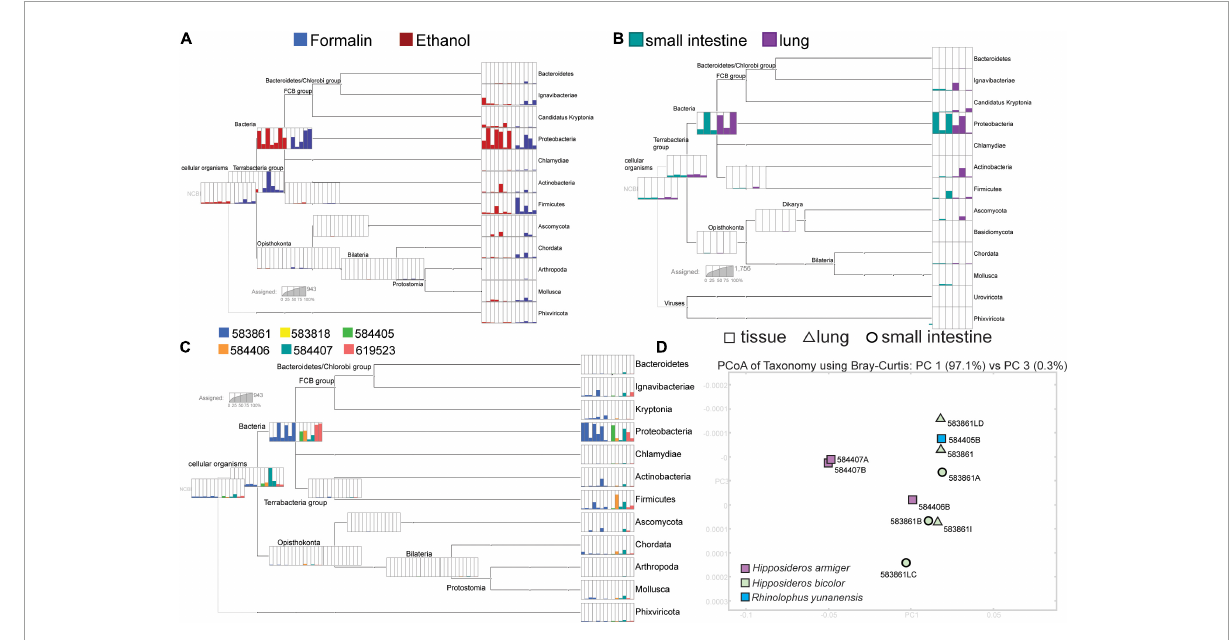
FIGURE3 Results from the MEGAN analysis. Parts A-C each have separate scales inset in each section to indicate read counts. (A) The relative composition of phyla detected from of each sequenced library separated by preservation type. (B) Variation in phyla recovered across lung and small intestine replicates from specimen USNM 583861 ( Hipposideros bicolor ). (C) The relative proportions of reads identified to phylum from each sequenced library, colored by individual bat (USNM ID). (D) A PCoA of all sequenced insectivorous bats, with PC’s 1 and 3 shown. Tissue type is indicated by the shape (corresponding to Figure 2 ), and color indicates the species as shown in the bottom left corner of the